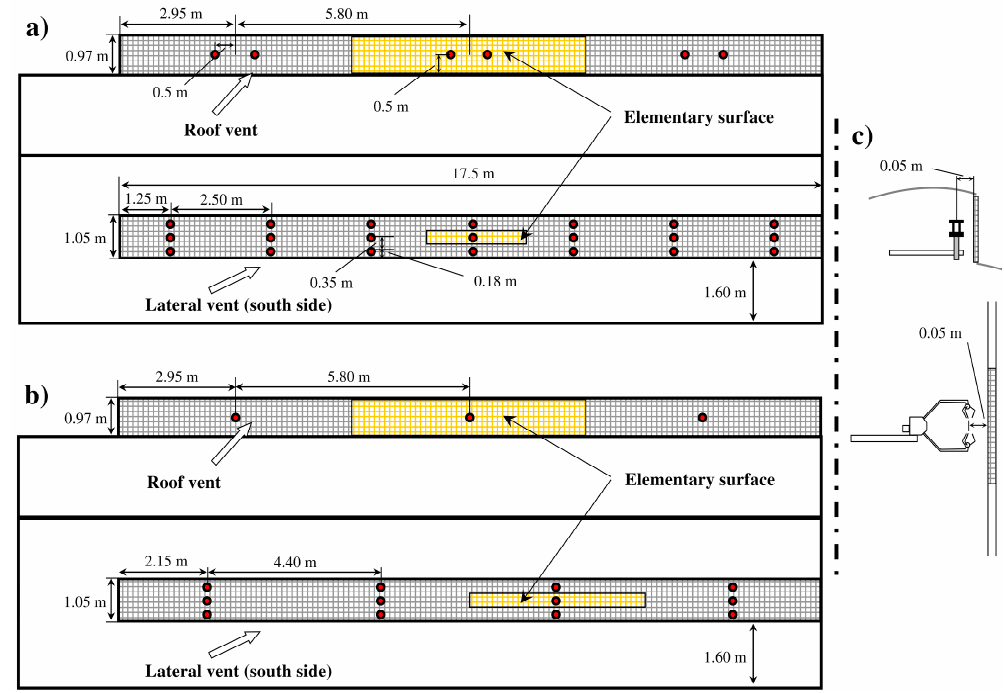
Figure 2. Measurement points at the lateral vents and at the roof vent (view for south side). Figure2. Measurementpointsatthelateralventsandattheroofvent(viewforsouthside). Measurement